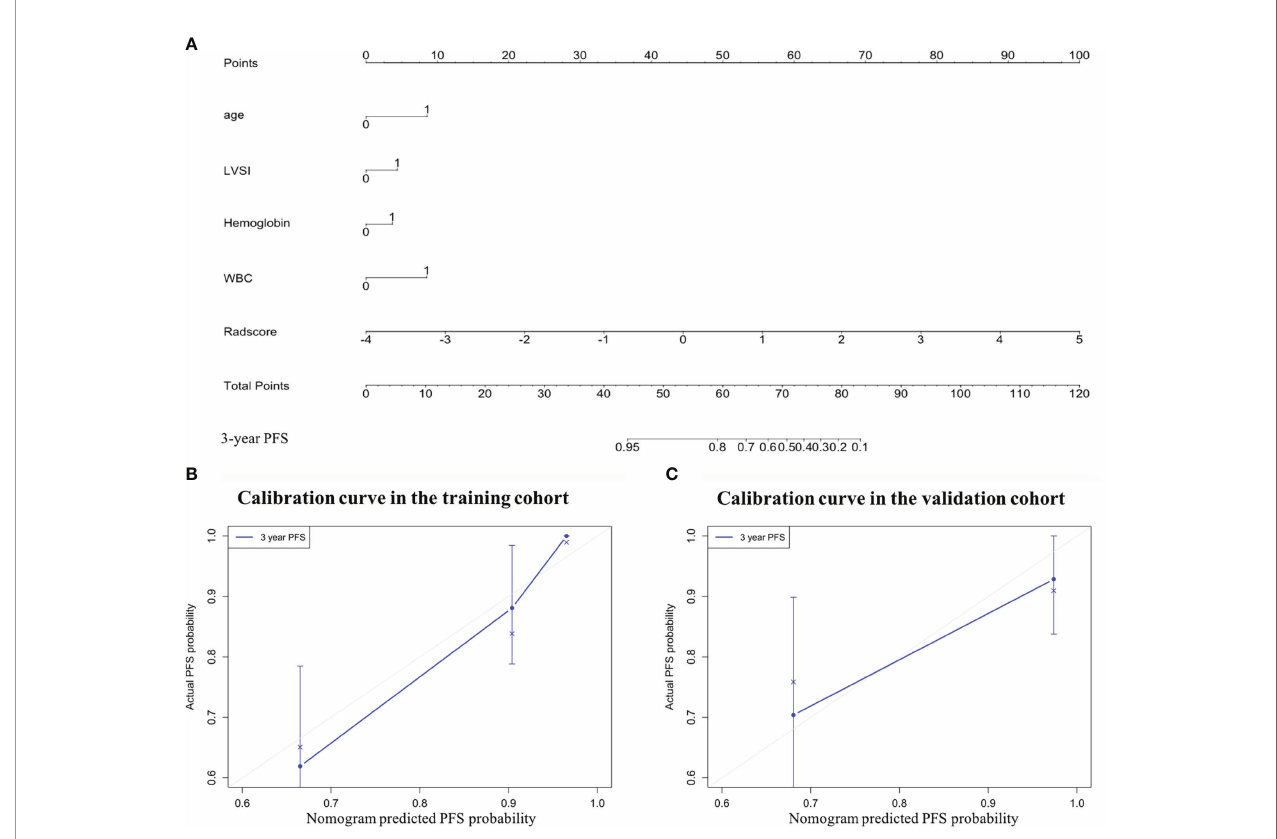
FIGURE 4 | The combined nomogram was developed to predict the risk of 3-year progression-free survival (PFS) of patients with locally advanced cervical cancer undergoing surgery. (A) The combined nomogram that integrates the Rad-score with the clinicopathologic features in the training data set. Calibration curves of the combined nomogram in the (B) training and (C) validation cohorts. The diagonal gray line represents a perfect evaluation, while the blue line represents the actual performance of the nomogram. A closer fi t to the diagonal gray line indicates a better assessment. LVSI, lymph vascular space invasion; WBC, white blood